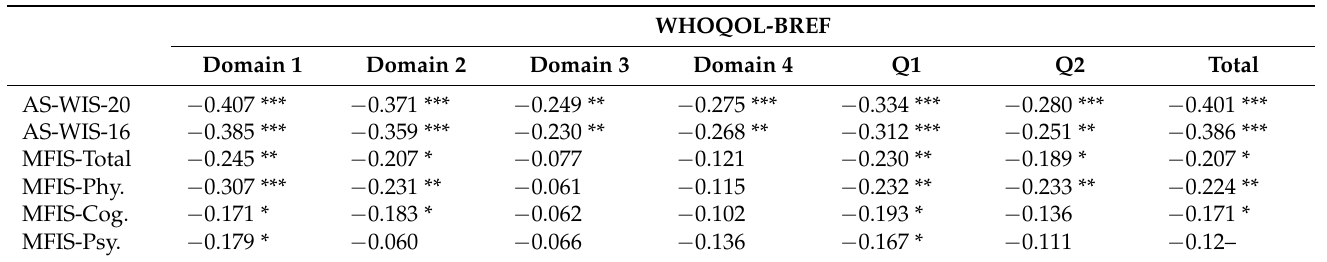
Table 3. Spearman’s rank correlation coefficients (Rho) between QoL scores (WHOQOL-BREF) and the risk of work disability (AS-WIS) and the level of fatigue (MFIS) in a group of 142 patients with RA.